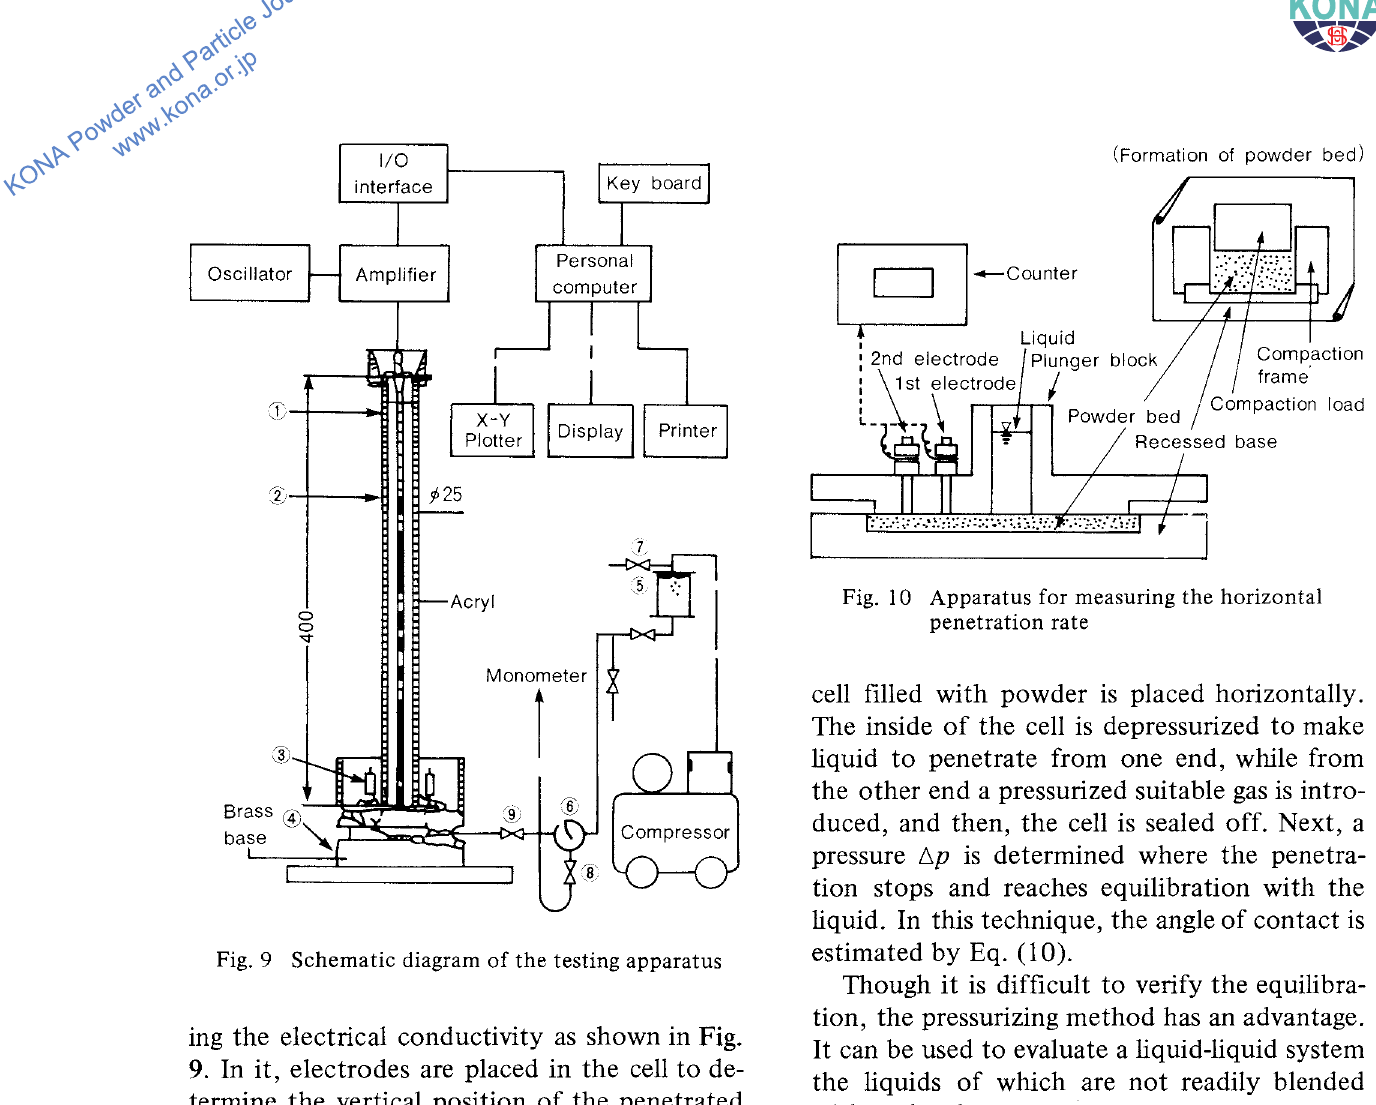
Fig. 1 0 Apparatus for measuring the horizontal penetration